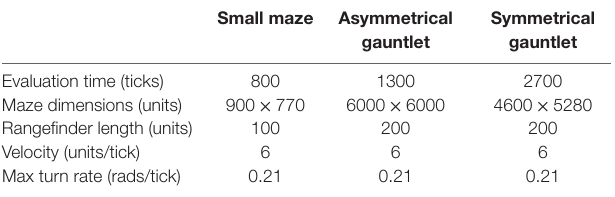
Reflecting differences in design and difficulty, some parameters vary between mazes.